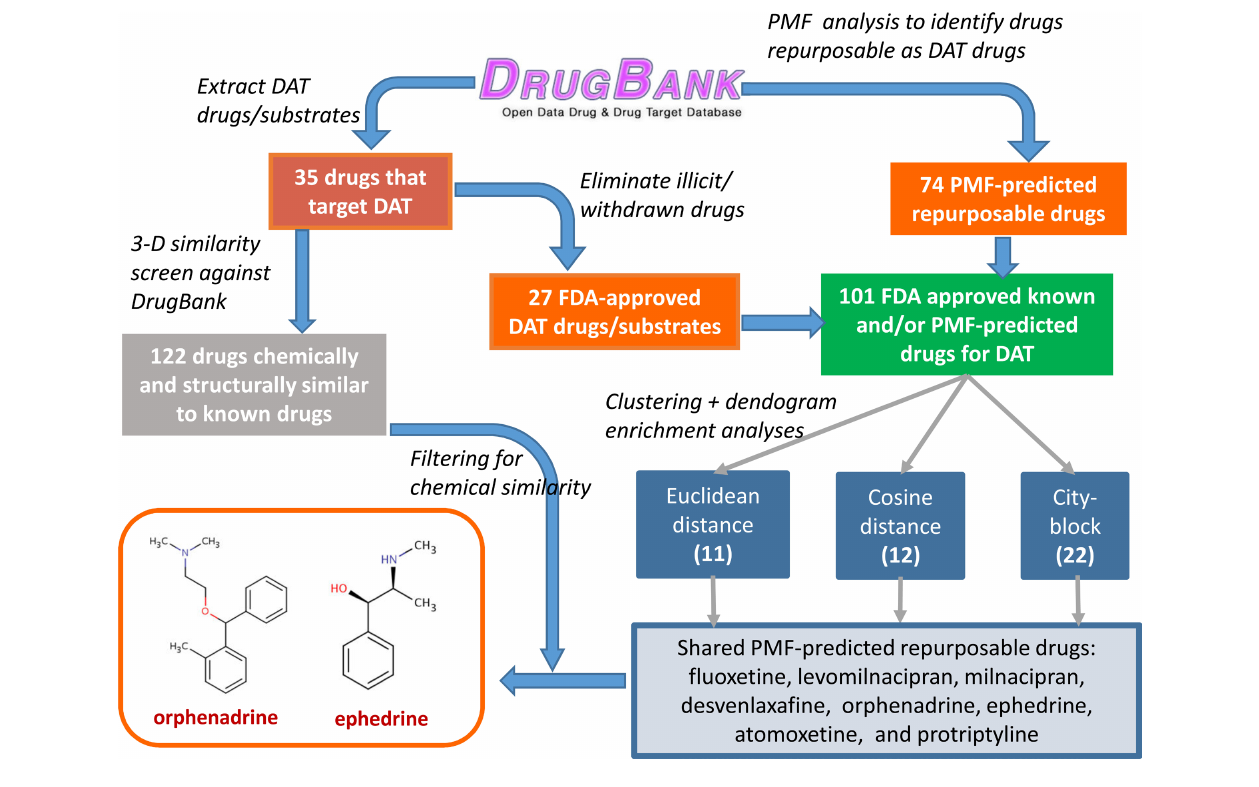
different distance metrics (Euclidian, cosine, and city-block). Screening of these drugs against the subset of 122 drugs identified by OpenEye screening to be structurally and chemically similar to known drugs distinguishes two, ORPH and ephedrine (followed by desvenlafaxine, not shown). See the text for details. The highest scoring drug, ORPH, is selected for computational and experimental